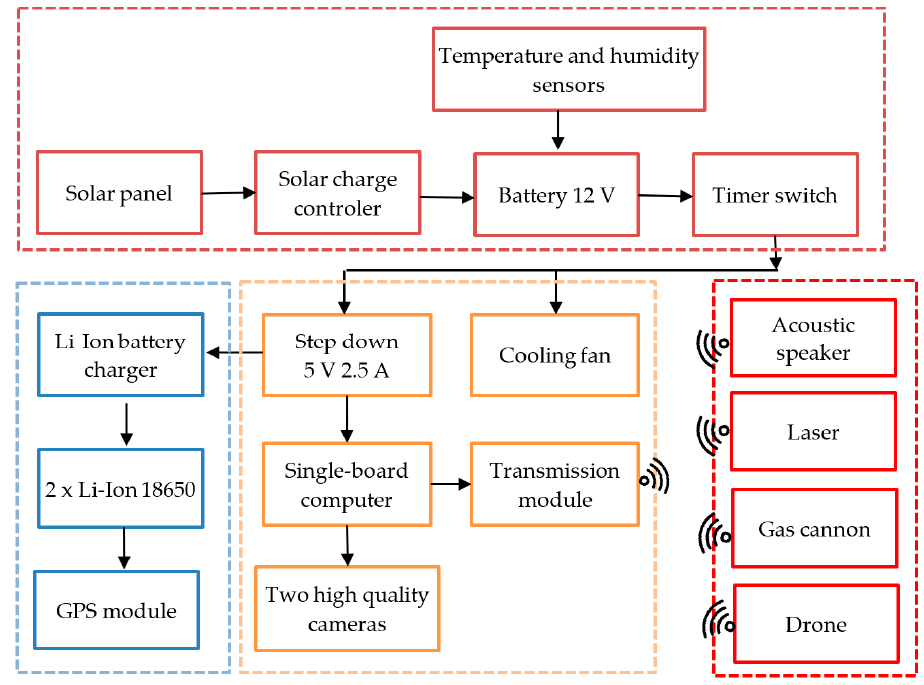
Figure 1. A block diagram of the sample setup for the detection of flying objects.